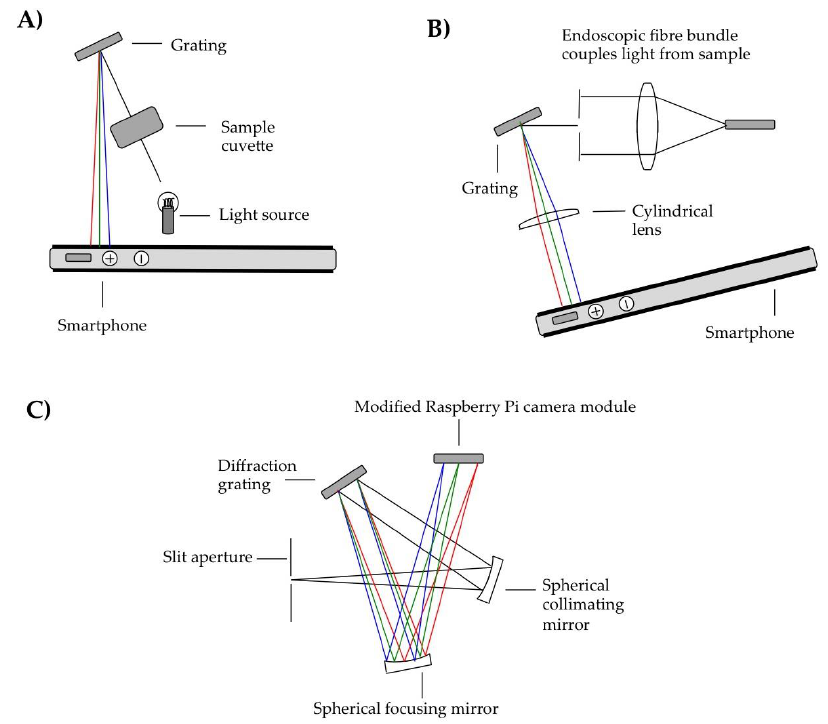
Figure 4. Sample developed reflective grating smartphone spectrometer concepts: ( A ) a straightforward protocol applied in both fluorescence and absorption modalities with diffraction achieved using either a CD or in-house constructed diffraction grating [38,39]; ( B ) an endoscopic approach, whereby probe type sampling was demonstrated, for example in food quality determination [40]; finally ( C ) a 3D printed Czerny turner design, incorporating a modified Raspberry Pi camera as the detector, which is based on a smartphone sensor [41]. The ray colouration provides a sense of the dispersion within these units, whereby the red rays signify the longer wavelengths, and the blue rays, the shorter ones. Please see main text for further details.